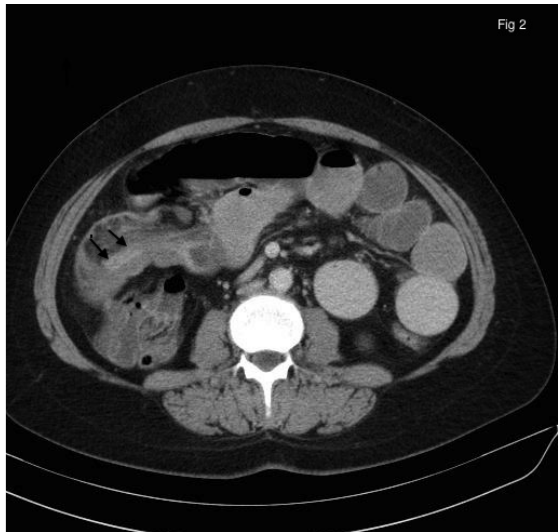
Figure 1. CT scan: Small Bowel Intussusception. Black arrow showing intussuscepting small bowel and proximal